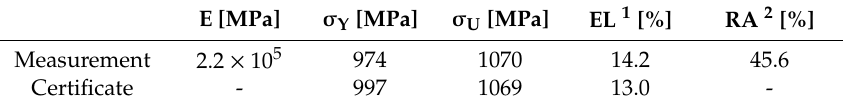
Table 2. Mechanical properties of used steel